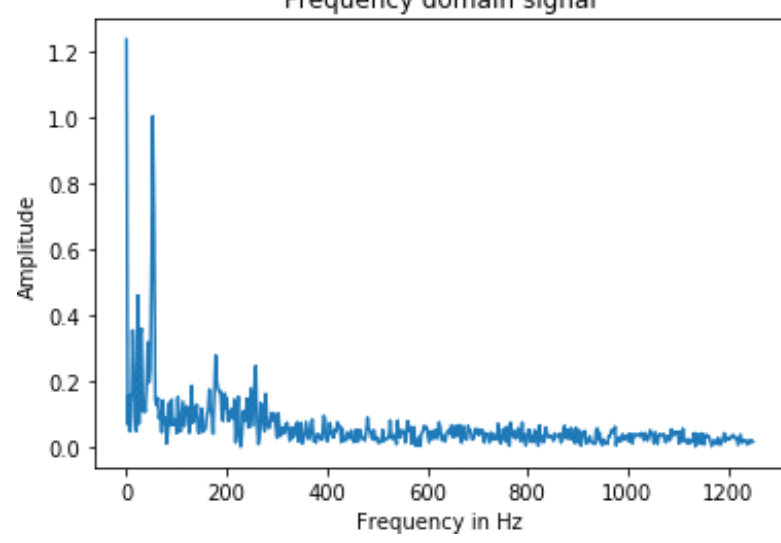
Figure 5: A sample signal representation of bad conditioned aircraft gearbox system in frequency